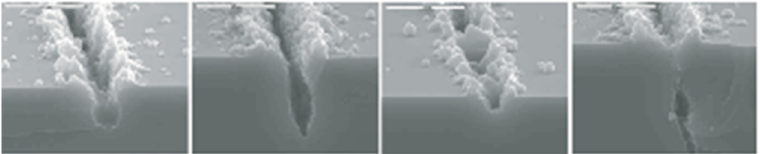
Figure 4. Example of resonant oscillator laser ablation profile from Newcastle University.